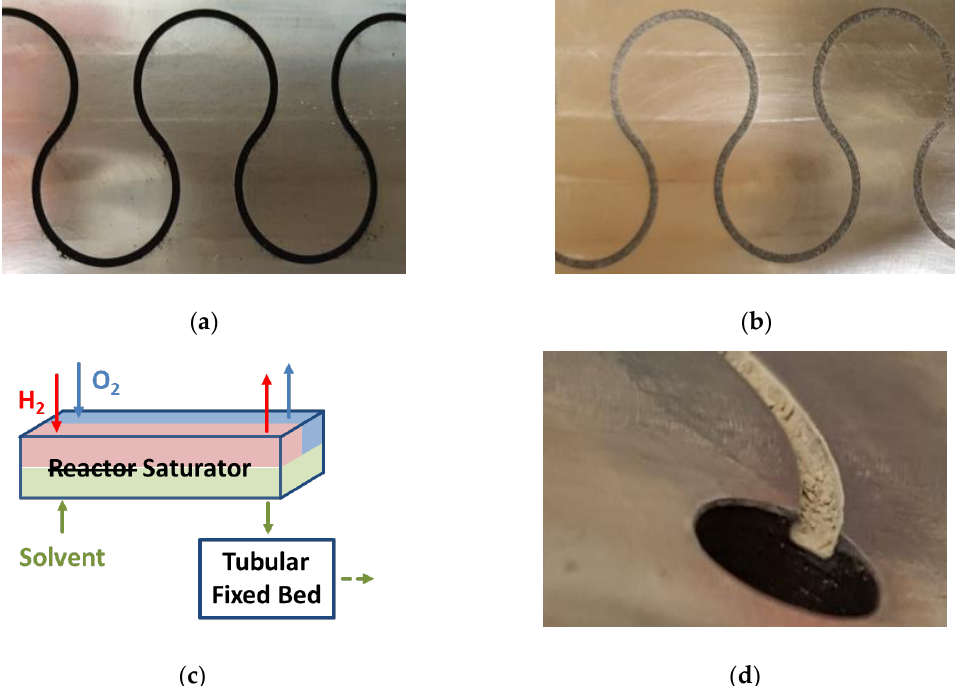
Figure 11. Photos and illustrations of the different catalyst arrangements tested: Pd/C micro channel fixed bed ( a ), Pd/TiO 2 micro channel fixed bed ( b ), catalyst arrangement with a tubular fixed bed ( c ) and Pd/TiO 2 micro channel coating ( d ).